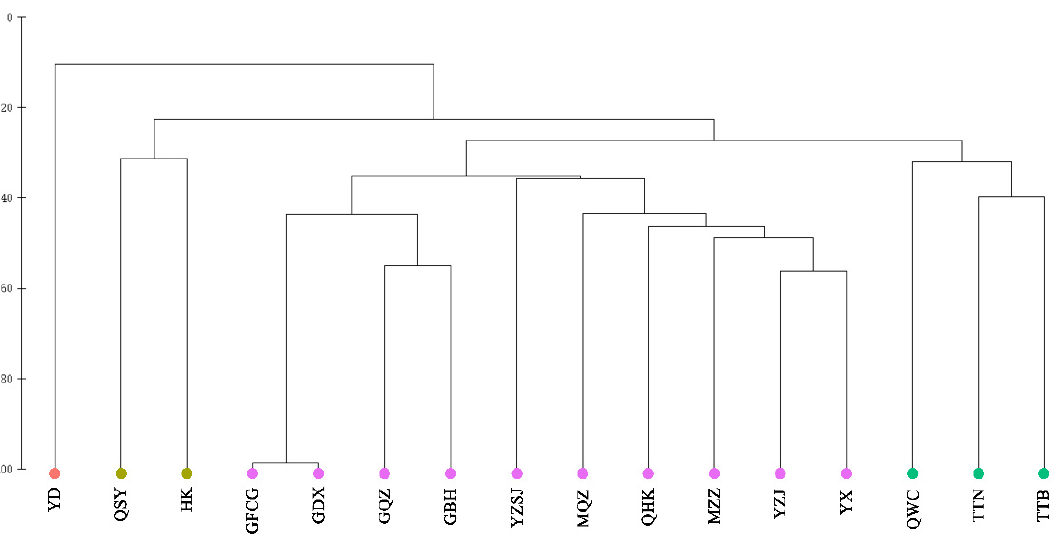
Figure 4. Cluster diagram of fish community structure in mangrove of China. YD: Eastern Guang- dong; QSY: Sanya, Hainan; HK: Hong Kong; GFCG: Fangchenggang, Guangxi; GDX: Dongxing, Guangxi; GQZ: Qinzhou, Guangxi; GBH: Beihai, Guangxi; YZSJ: Pearl River Delta; MQZ: Quan- zhou, Fujian; QHK: Haikou, Hainan; MZZ: Zhangzhou, Fujian; YZJ: Zhanjiang, Guangdong; YX: Western Guangdong; QWC: Wenchang, Hainan; TTN: Tainan, Taiwan; TTB: Taipei, Taiwan.